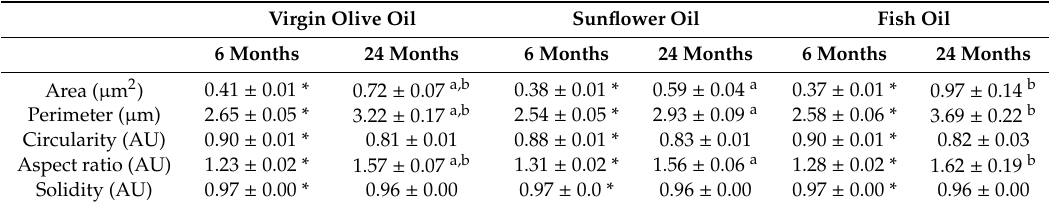
Table 4. Heart mitochondrial morphometric parameters in rats fed for 24 months on virgin olive oil, sunflower oil or fish oil.